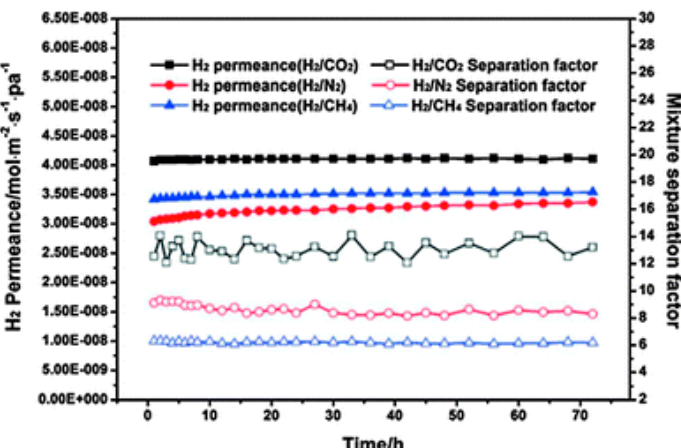
Figure 19. H 2 permeance and separation factors in the volume ratio binary gas mixture H 2 –CO 2 , H 2 –N 2 , and H 2 –CH 4 systems of HKUST-1 membrane as a function of time at 40 °C with a pressure drop of 1 atm (adapted with permission from ref. [114]).